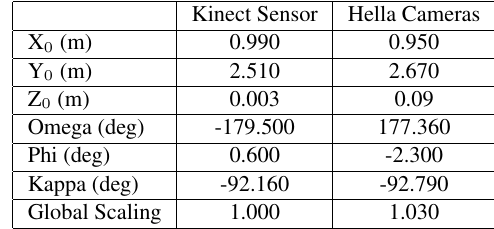
Table 3: Similarity transformation parameters for Kinect Sensors and Hella Cameras